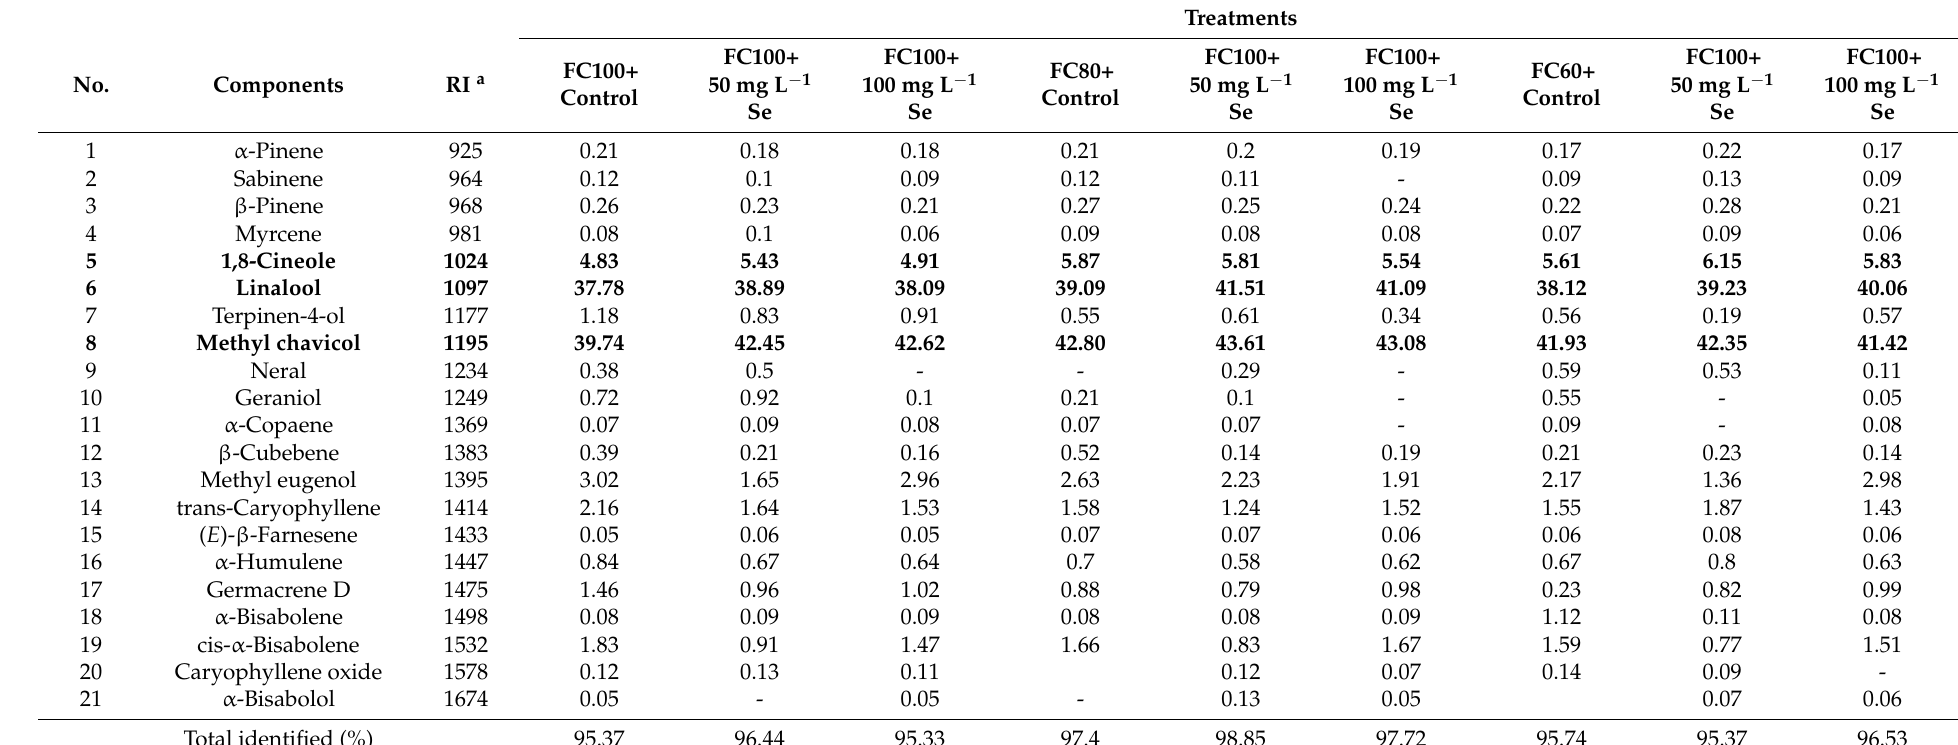
Table 3. The essential oil constituents of basil in different irrigation regimes and Se NPs.